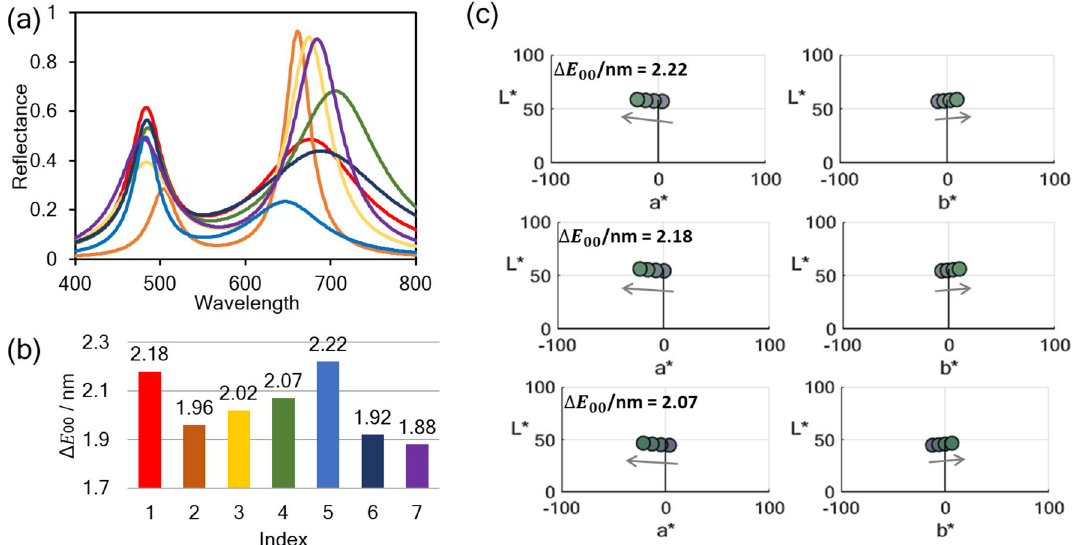
Figure 3. ( a ) Seven target spectra finally established in consideration of maximization of color difference per refractive index unit and visible loss of silicon. ( b ) Δ E 00 /RIU values calculated for each target spectrum. ( c ) For three target spectra with the highest Δ E 00 /RIU values, when the spectrum is laterally shifted by 5 nm, variations of colors are represented on two-dimensional section of CIELAB coordinate. The color inside the circle shows the reflected structural color calculated for each